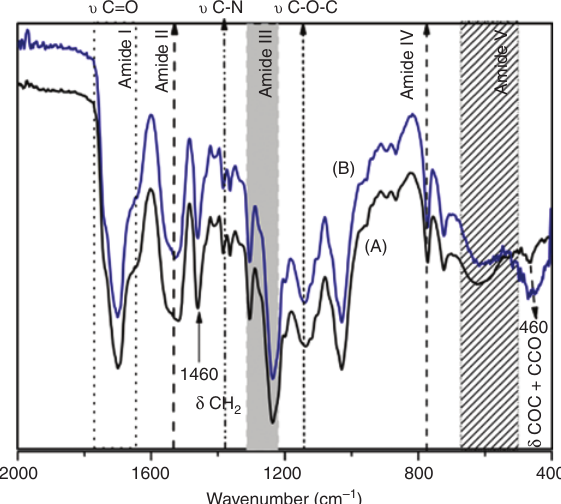
Figure 4: Infrared spectra of waterborne polyurethane (PU) prepoly- mer (A) WPUDCO-1 and (B) WPUDCO-2 2000–500 cm − 1 along with their characteristic